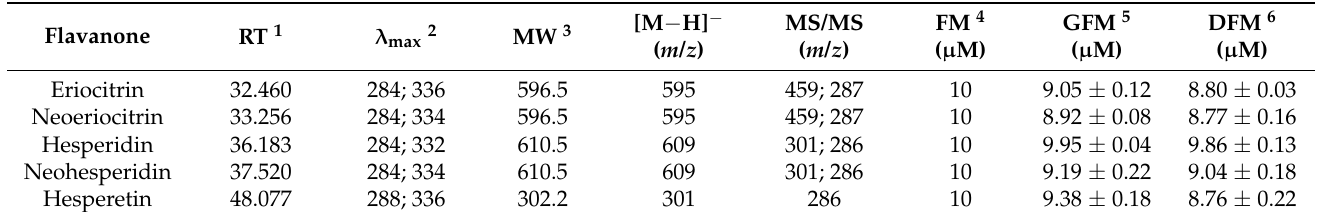
Table 2. Quali-quantitative analysis of flavanones mix pre-and post-simulated human digestion.